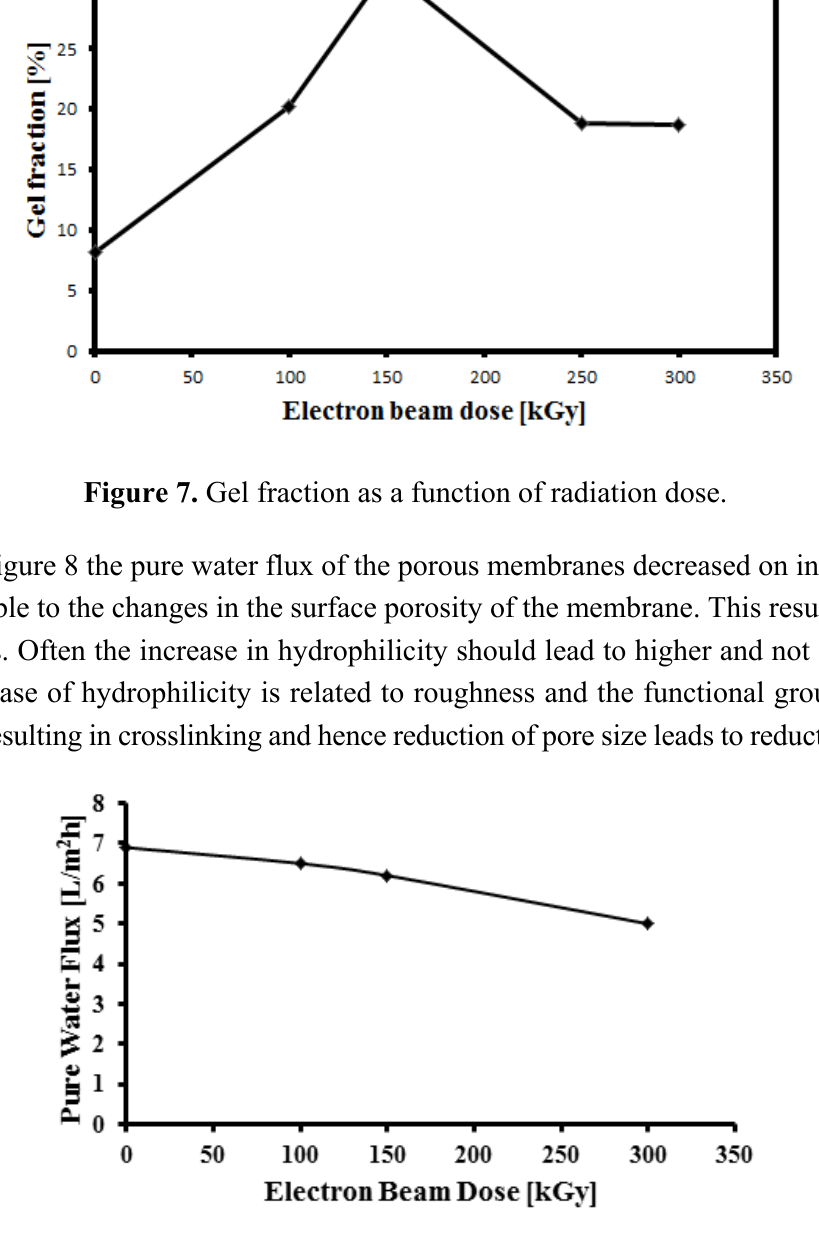
Figure 8. Pure water flux as a function of radiation